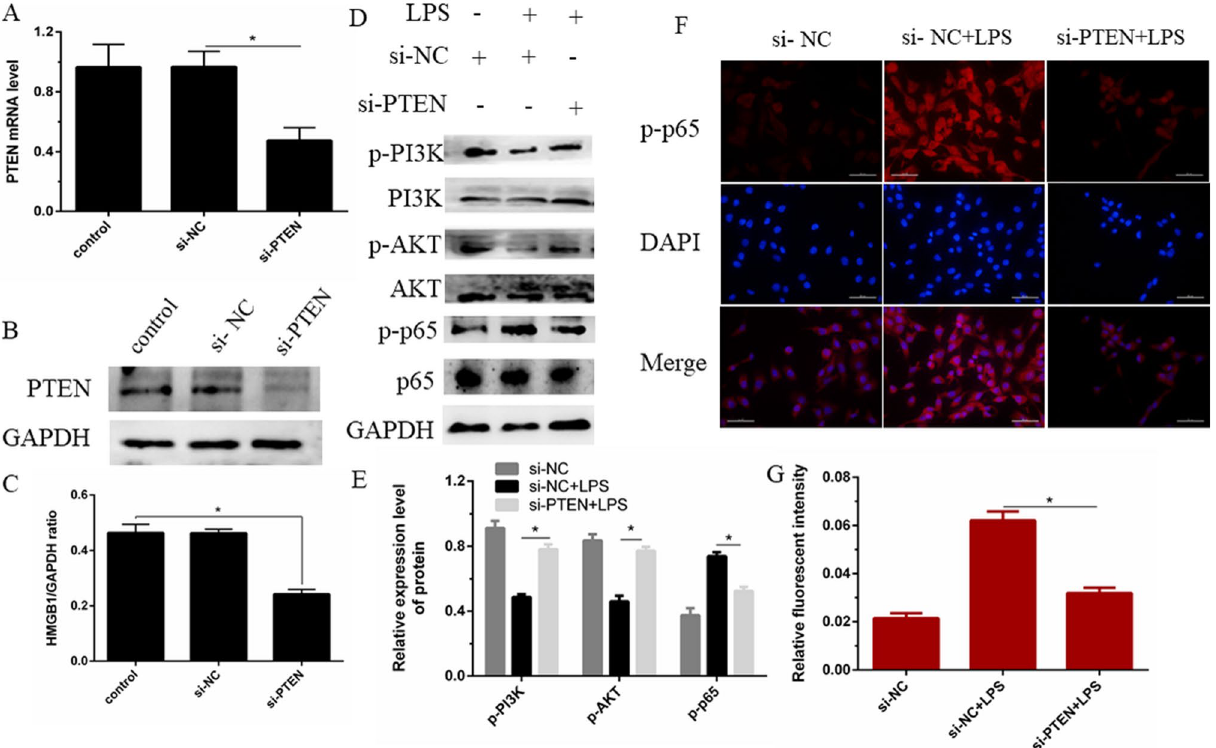
Figure 8. PTEN knockdown hinders the activation of NF-κB axis via activating PI3K/AKT signaling. ( A ) Transfected bEECs with PTEN-specific siRNA (si-PTEN) or negative control siRNA (si-NC) at a concentration of 200 nM after 24 h. qPCR to evaluate the mRNA level of PTEN. ( B ) The cell treatment was the same as ( A ), and the expression of PTEN was evaluated by western blotting. ( C ) IPP6.0 calculated the PTEN gray level, and GAPAH is the internal reference. ( D , E ) After the cells were transfected with si-PTEN or negative control siRNA (si-NC) for 24 h, the cells were treated with 2 µg/mL LPS for 24 h. Western blot was used to detect the phosphorylation levels of PI3K, AKT and p65. Calculated the protein gray level, GAPDH employs as an internal control (Supplementary information). ( F , G ) After the cells were processed in the same way, the nuclear translocation of p65 was detected by immunofluorescence. The area of IOD/area was calculated by IPP6.0 software. Data are expressed as mean ± S.D., Three independent experiments. * p < 0.05. The cropping of your gels and blots in the figure legends where